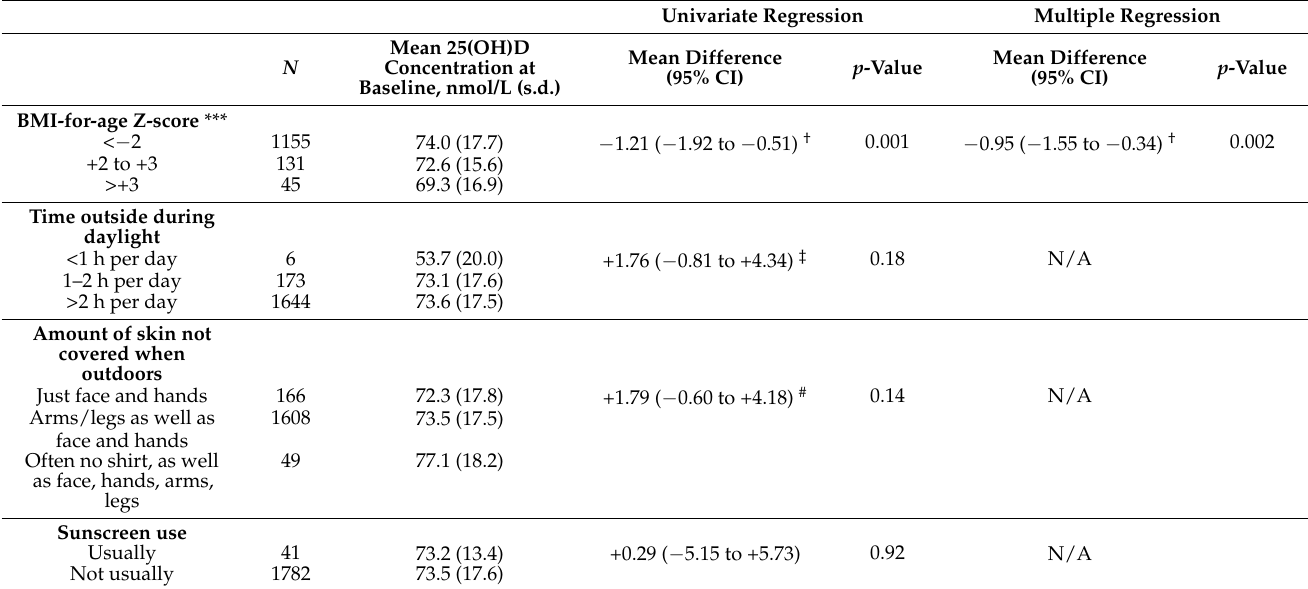
Table 1. Cont. Univariate Regression Multiple Regression